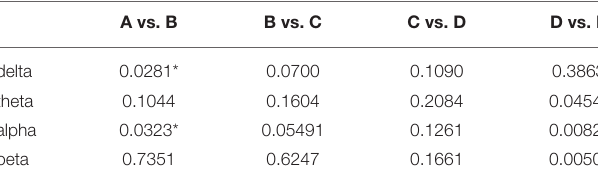
TABLE 3 | Comparison of coherence analysis ( p